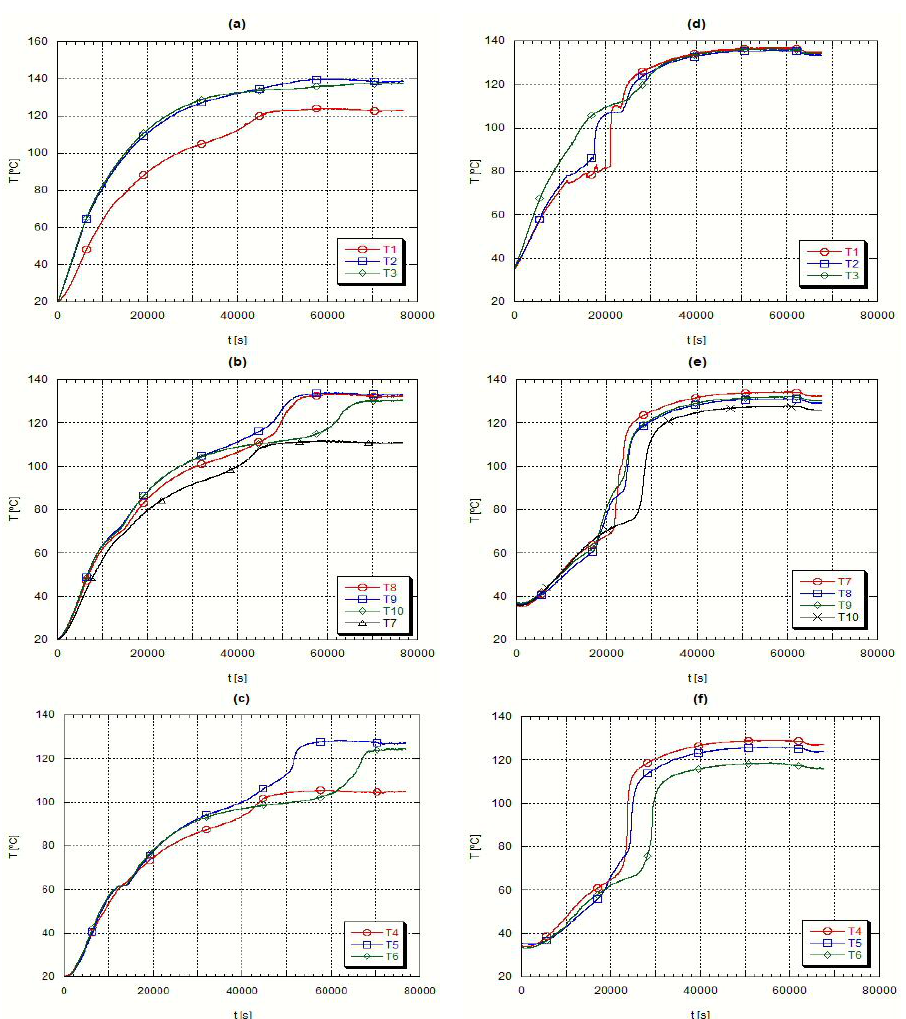
Figure 4. Axial evolution of phase change materials temperature during fusion. Plots ( a – c )—H105; Plots ( d – f )—A82.